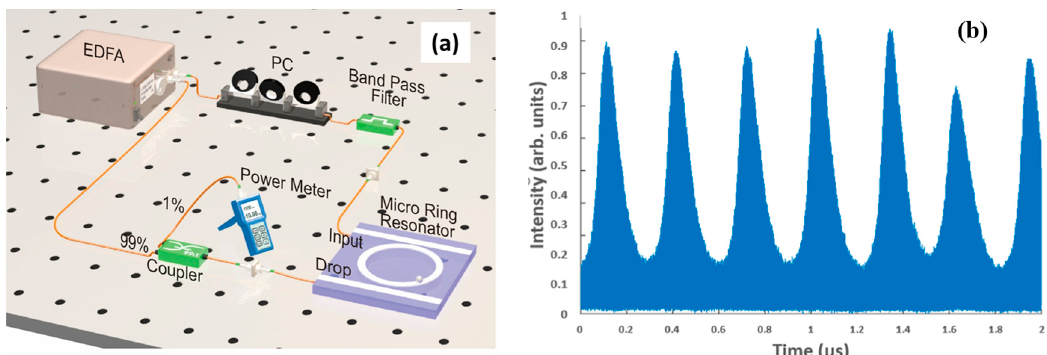
Figure 1. ( a ) The optical trapping system with a highly-doped silica glass ring resonator in a self-locked configuration, EDFA is an erbium-doped fiber amplifier, and PC is a three-ring polarization controller. ( b ) The fast detector output from the tap showing Q-switching in the fiber loop cavity. The repetition rate of the Q-switched pulses is approximately 100 kHz with the high frequency component within the Q-switched pulses at 6.6 MHz, which corresponds to a fiber loop length of 30 m.